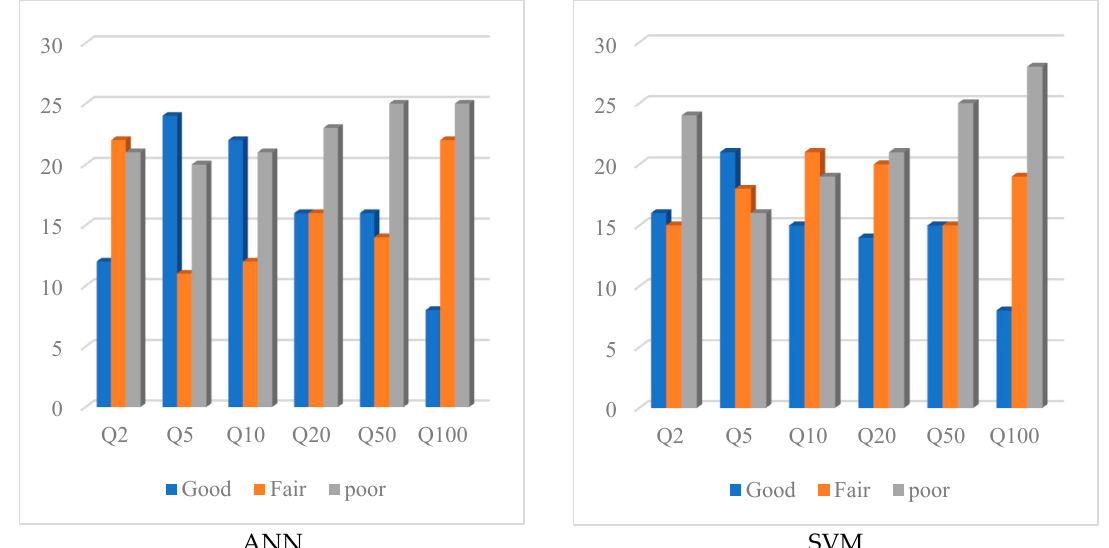
Figure 8. Number of stations (testing dataset) based on Q ratio for the ANN and SVM models.